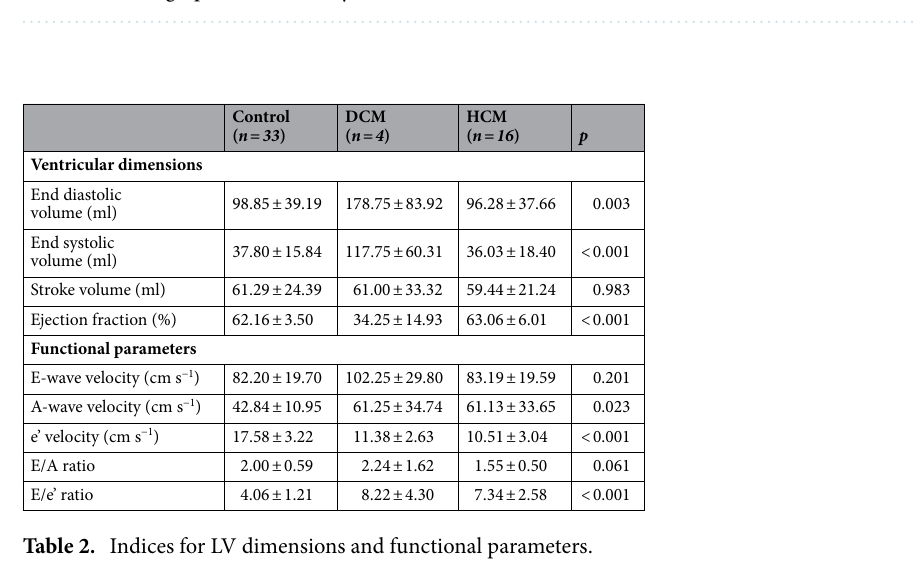
Table 1. Demographics of the study cohort for each disease state.